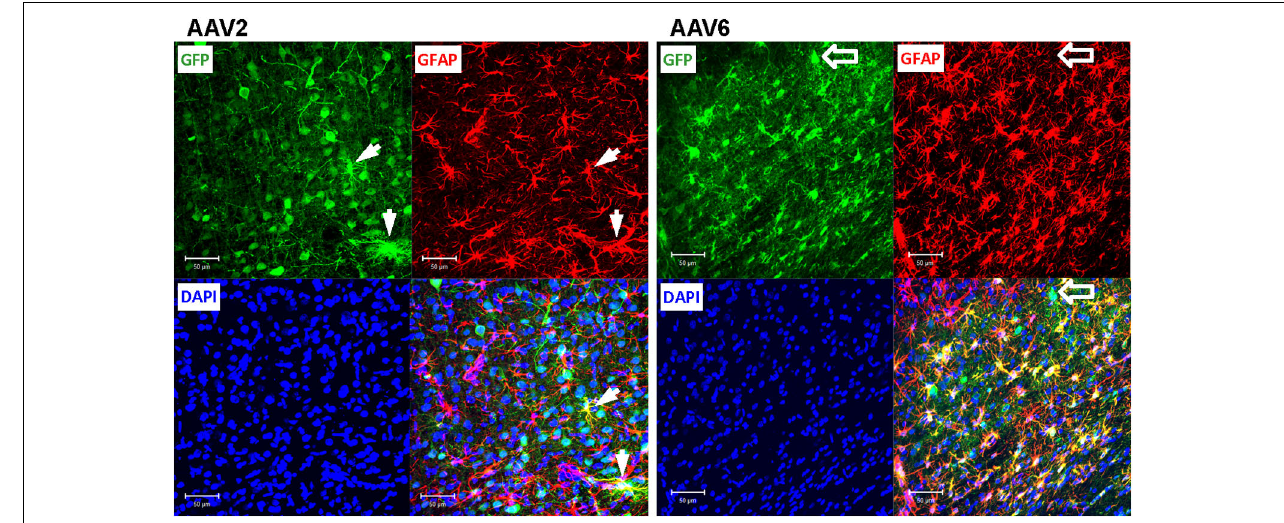
FIGURE 5 | Astrocytic tropism of rAAV2 and rAAV6 in the rat cortex. Slices were stained for GFP as a marker of viral transduction (green), the astrocytic marker GFAP (red), and DAPI (blue). White arrows point to a few rAAV2-infected astrocytes (GFP + /GFAP + cells for rAAV2). Although the vast majority of the AAV6 transduced cells were GFAP-positive, block arrows point to an exception, the rAAV6-transduced neuron-like cell (GFP + /GFAP- cell). Images were taken using a Zeiss LSM510 META confocal microscope at 250 × magnification. Scale bars = 50 µ m. Images are representative of at least 12 sections from four different rats for each virus.